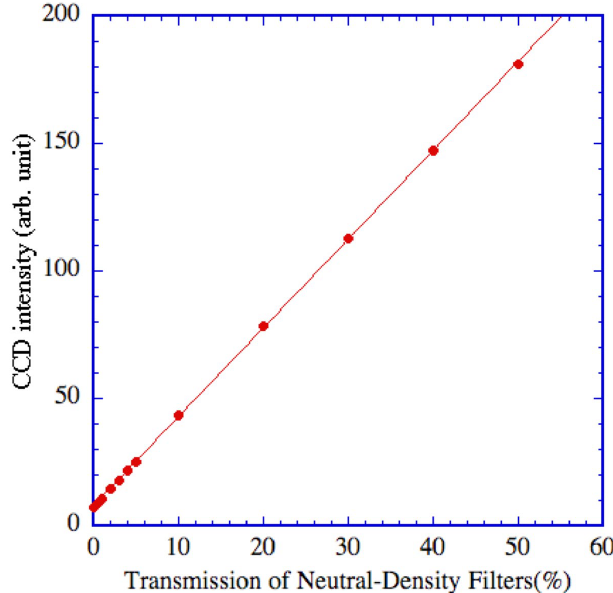
FIG. 6. (Color) Linearity of the CCD